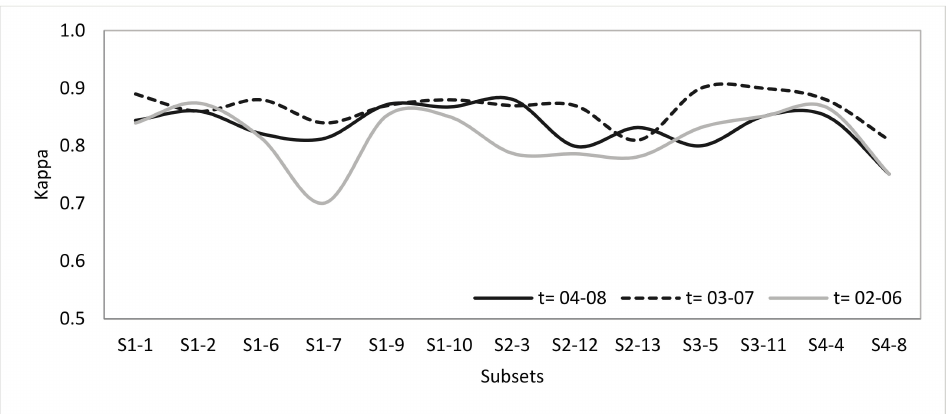
Figure 7. Estimation of threshold interval for random sets based on the optimal n selected for each subset. Threshold interval = 0.3–0.7 generally produced the highest κ value. S a − b : the name of subsets, a is the group number ( a = 1,..,4 ) and b is the subset number ( b = 1, . . . 13 )